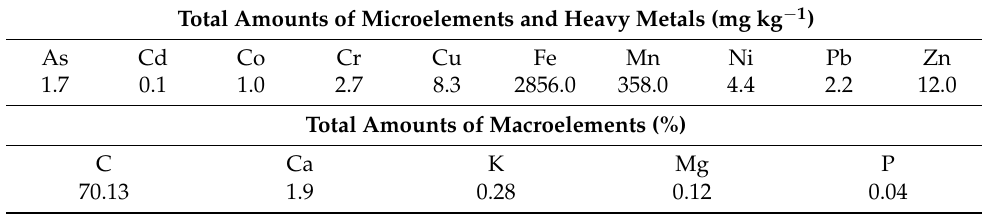
Table 3. Chemical characterization of biochar.